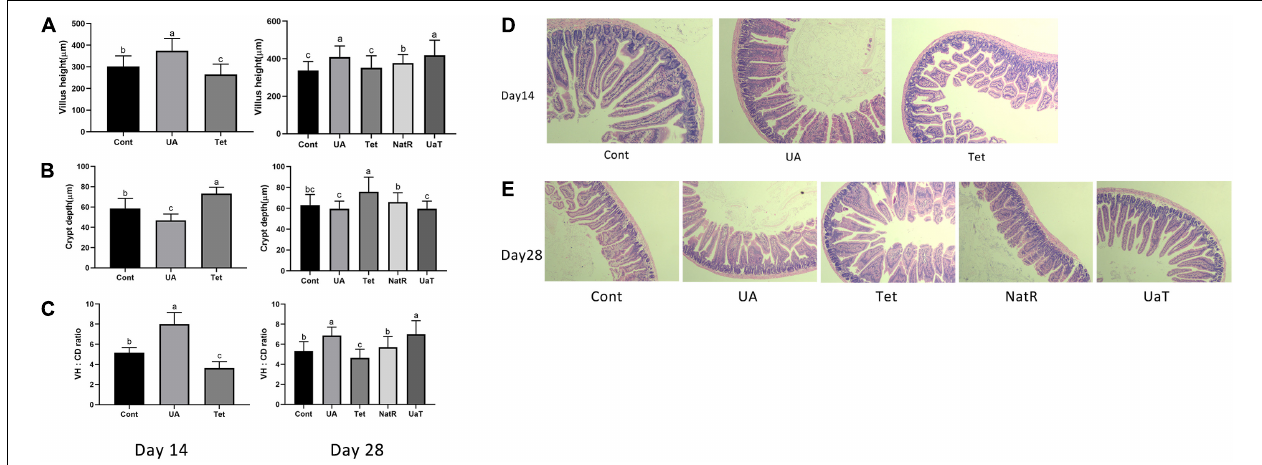
FIGURE 2 | Administration of ursolic acid attenuates antibiotic-induced jejunal morphological damage. Villus height (A) , crypt depth (B) , and VH: CD (C) in the jejunum of mice. Histology picture of jejunum in mice (D,E) . Day 14: Control (Cont) indicates the Non-treatment group, Chlortetracycline (Tet) indicates basal diet supplemented with 659 mg/kg chlortetracycline for 2 weeks, Ursolic acid (UA) indicates basal diet supplemented with 150 mg/kg ursolic acid for 2 weeks. Day 28: Control (Cont) indicates the Non-treatment group, Chlortetracycline (Tet) indicates basa diet supplemented with 659 mg/kg chlortetracycline for 4 weeks, Ursolic acid (UA) indicates basal diet supplemented with 150 mg/kg ursolic acid for 4 weeks, Natural restoration (NatR) indicates basal diet supplemented with 659 mg/kg chlortetracycline for 2 weeks and then feed with basal diet, Ursolic acid therapy (UaT) indicates basal diet supplemented with 659 mg/kg chlortetracycline for 2 weeks and then supplemented with 150 mg/kg ursolic acid for 2 weeks. Data are shown as means ± standard deviations. Statistically significance results between each treatment group on days 14 and 28 were expressed by lowercase letters (a, b, c) based on ANOVA with Duncan’s range tests. Mean values with different letters indicate statistically significance results ( P < 0.05). n = 6 mice per group.